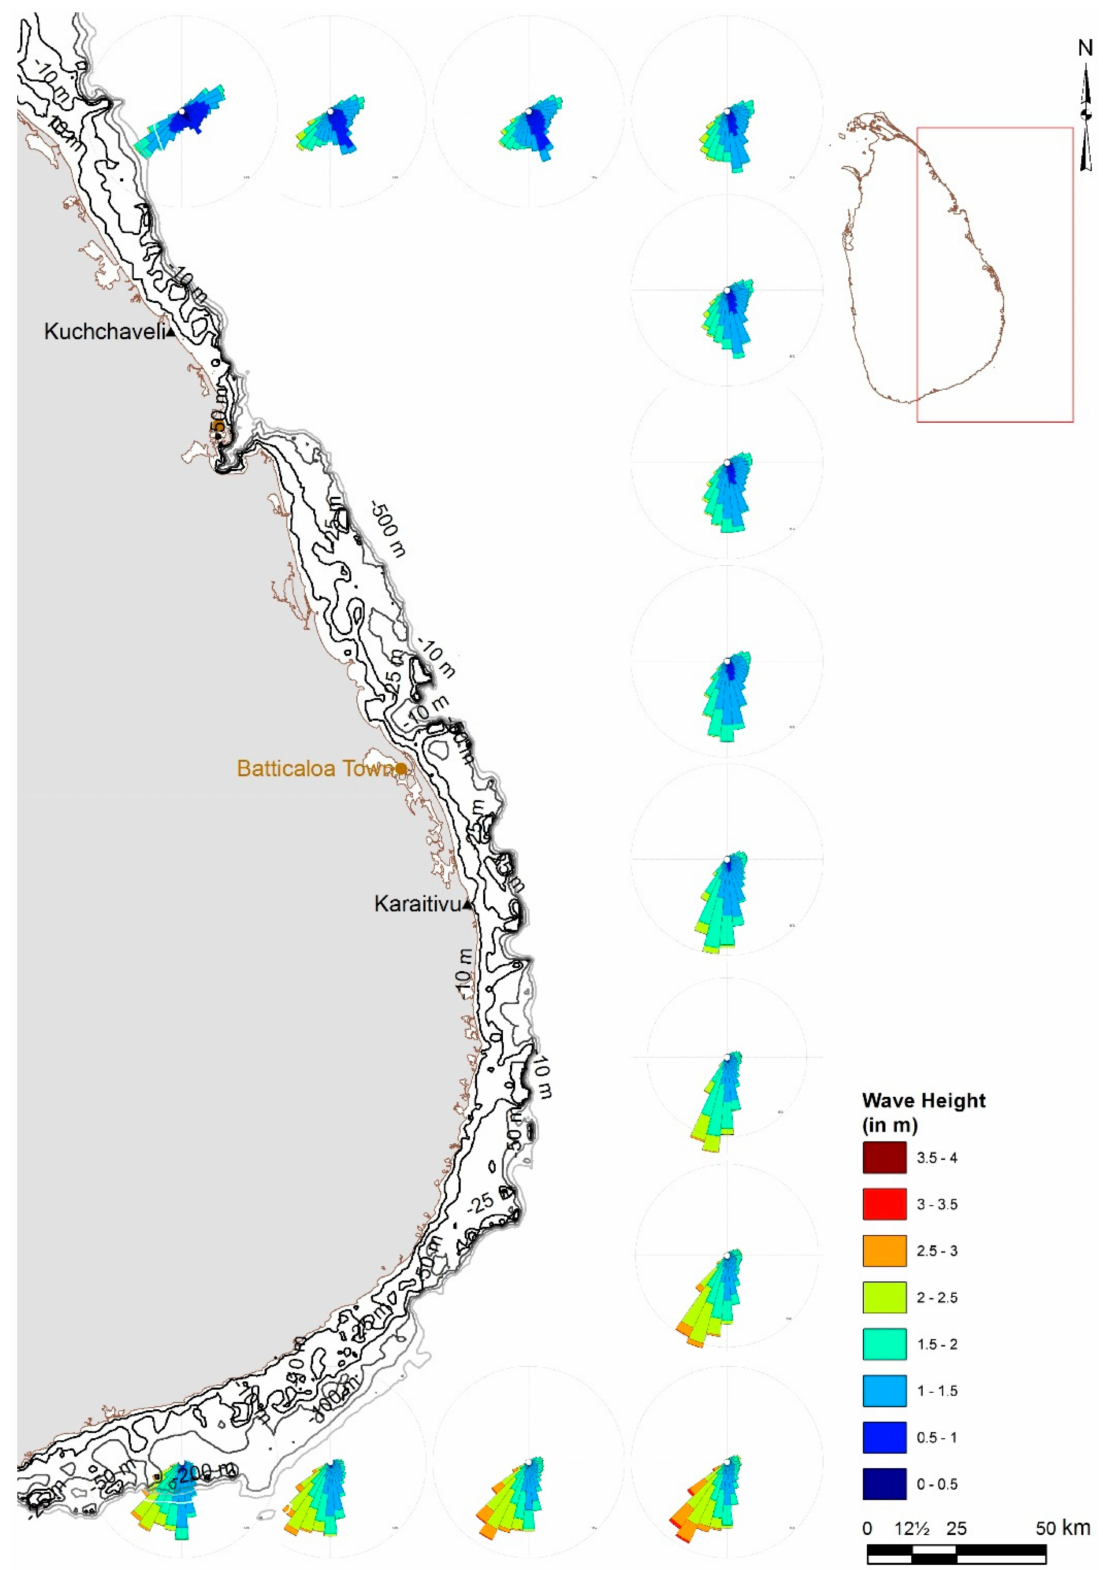
Figure 5. Wave boundary conditions applied to the model as time series of wave